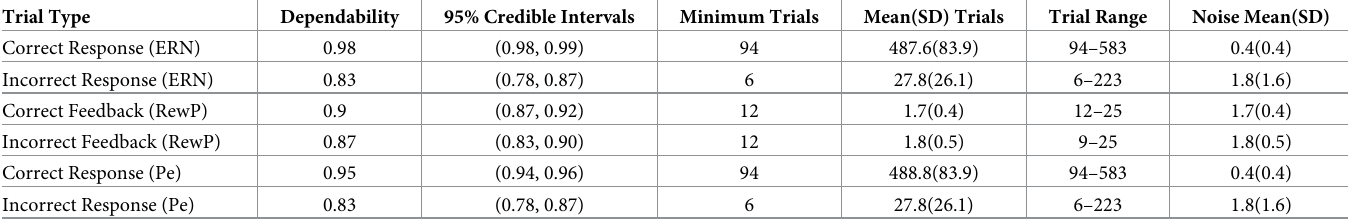
Table 2. ERP dependability and noise